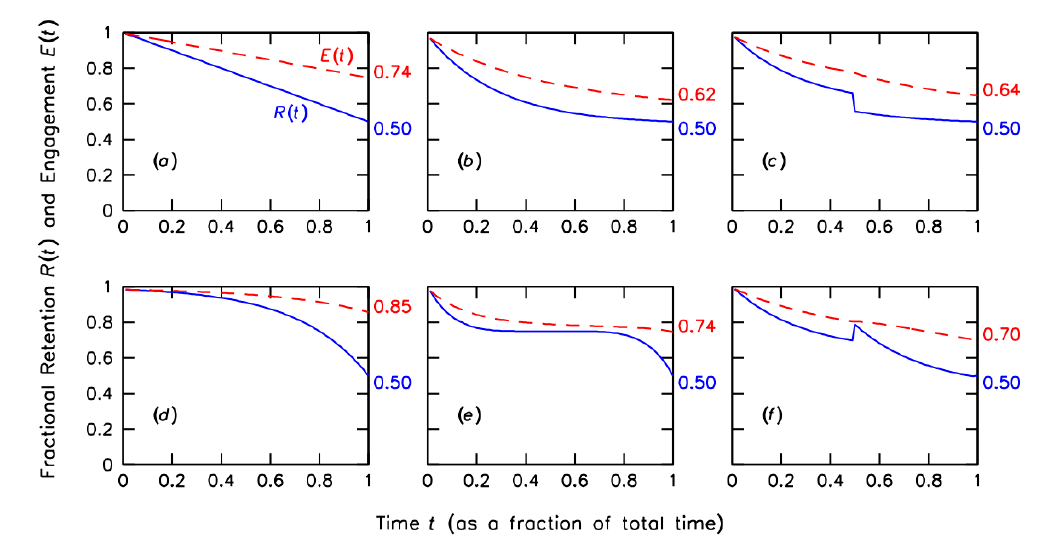
Note. Graphical difference between our definitions of instantaneous (a) retention, R( t ), and (b) engagement, E( t ), in terms of retention plotted over time. E( t ) is calculated by dividing the solid area under the curve (in blue) by the area of the open rectangle (in red) bounded by t